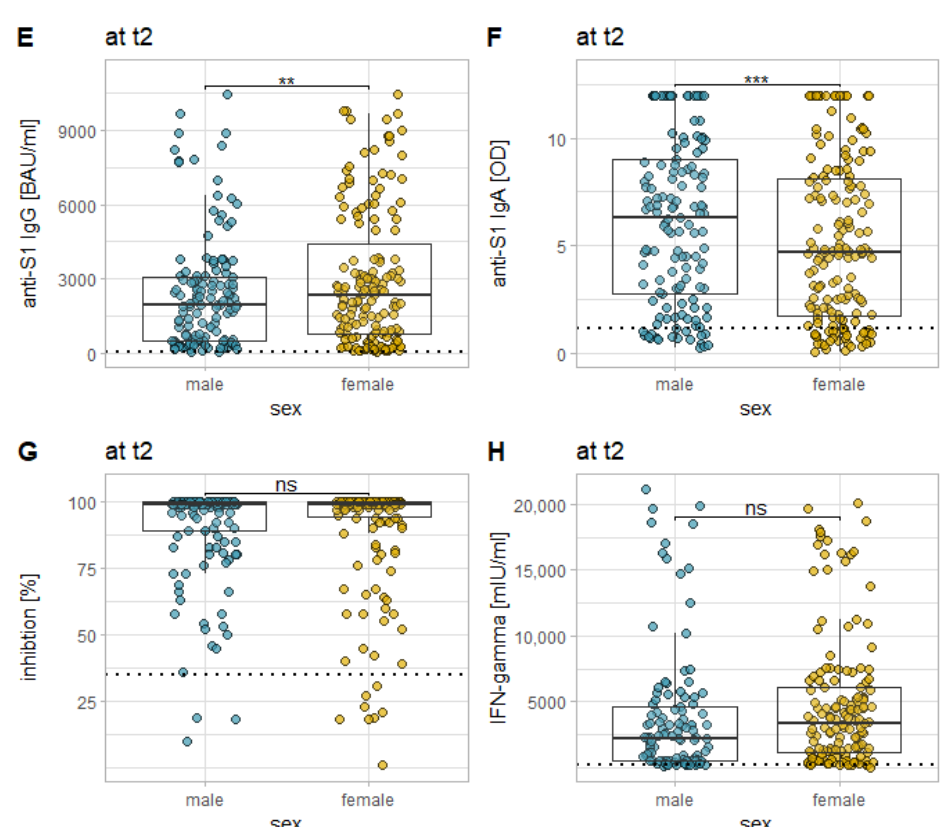
Figure 4. Comparison of the examined immune responses, both 12 weeks after the first vaccination ( A – D ), and 14 days after the second vaccination ( E – H ) in between the sexes (for all vaccination regimes of the current study cumulatively). Each plot represents a different marker: anti-S1 IgG ( A , E ), anti-S1 IgA ( B , F ), the inhibition by neutralizing antibodies ( C , G ), and T-cell response as measured via IGRA ( D , H ). The dotted horizontal lines represent the cutoff for reactivity of the different assays. * = p < 0.05; ** = p < 0.01; *** = p < 0.001; **** = p < 0.0001; ns = not statistically